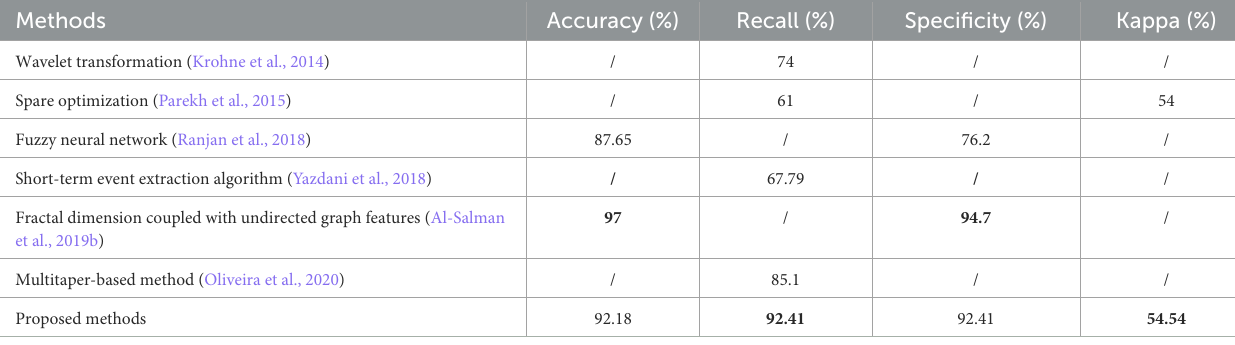
TABLE 4 Performance comparisons between the proposed method and other different detection methods with the same datasets based on Scenario 1.